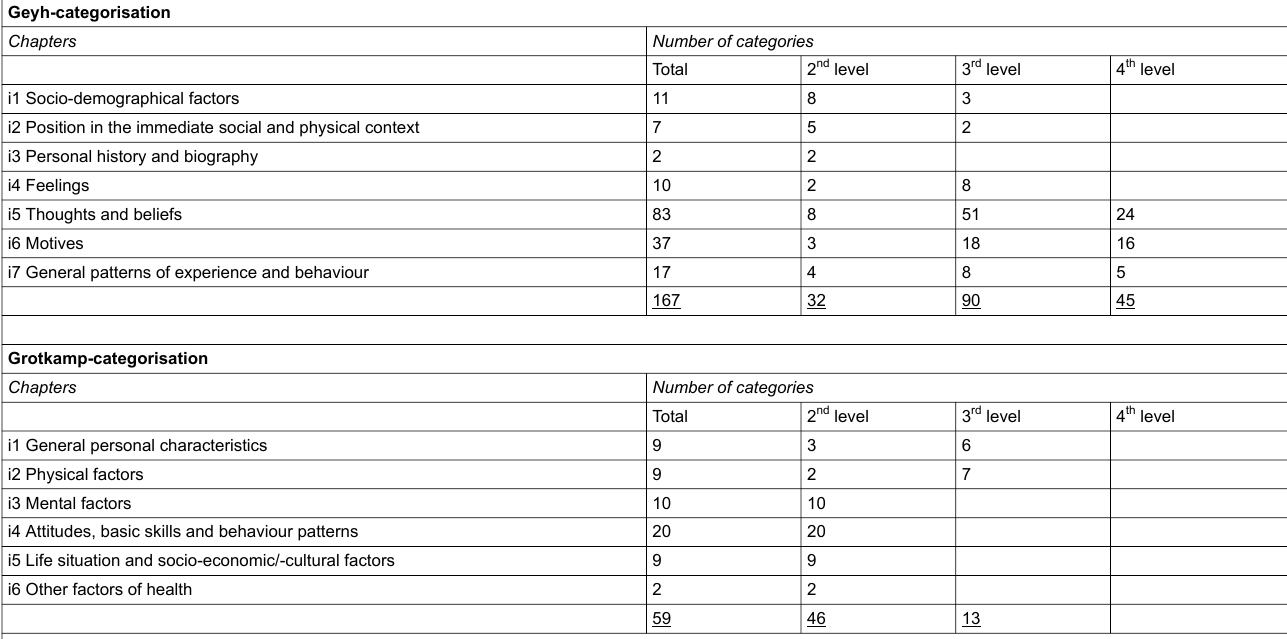
Table 1: Overview of the personal factor categorisation by Geyh et al. and Grotkamp et al. Geyh-categorisation